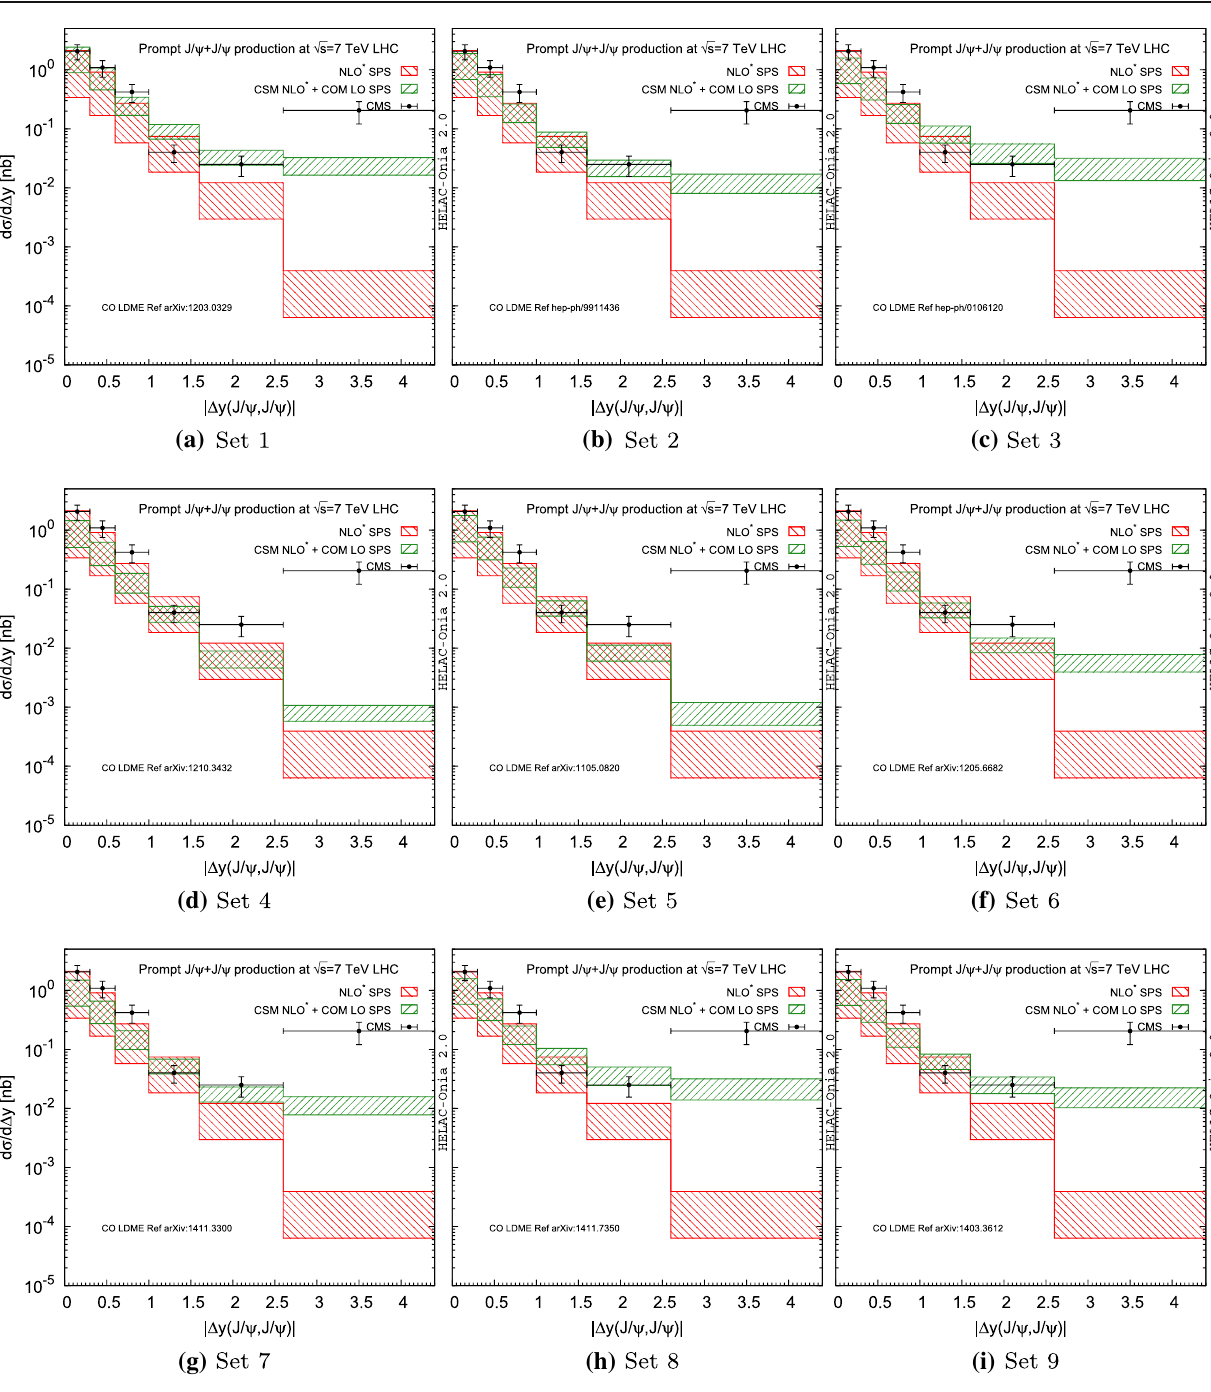
Fig. 6 Δ y ( J /ψ, J /ψ) distributions in NLO (cid:11) CS and LO CO via SPS within CMS